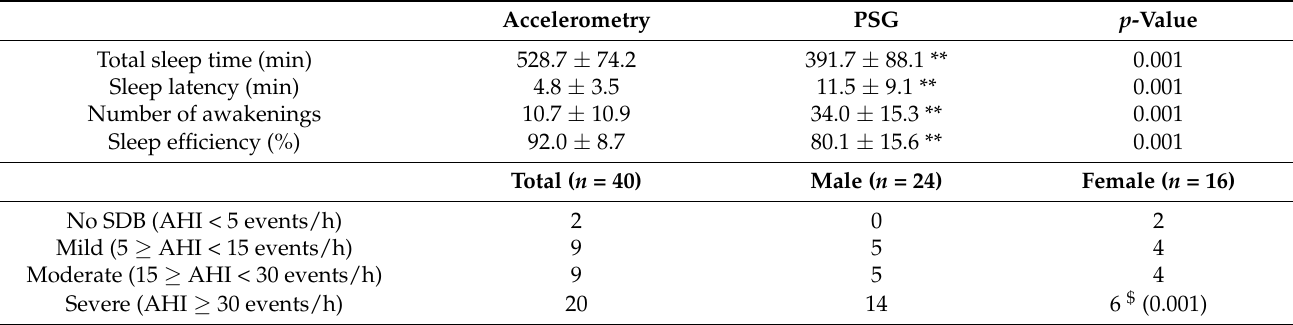
Table 2. Characteristics of sleep- and AHI-based classification.